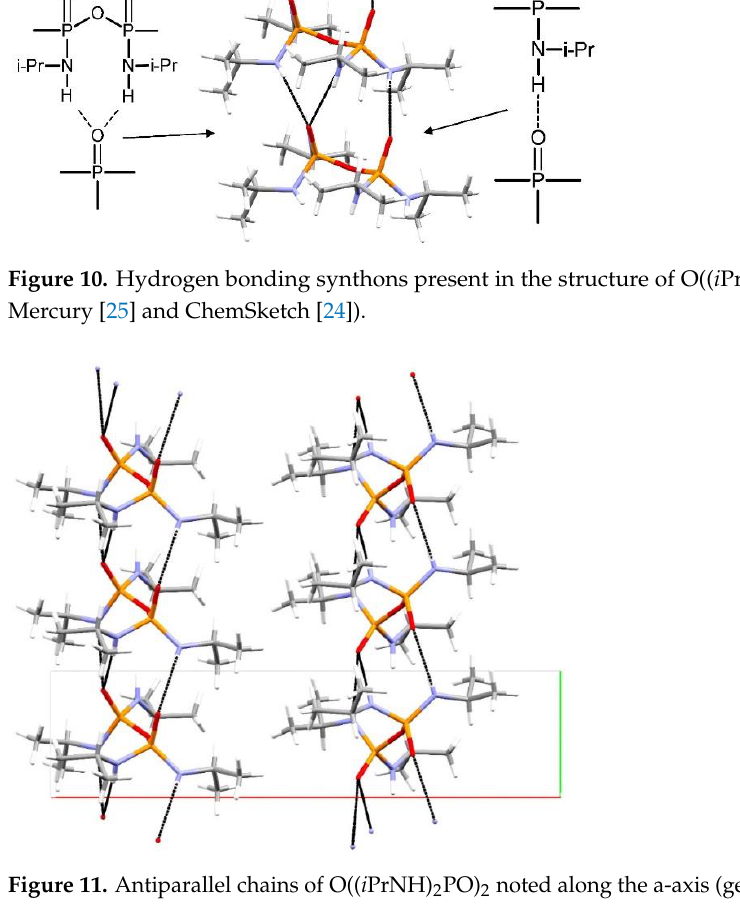
Figure 11. Antiparallel chains of O(( i PrNH) 2 PO) 2 noted along the a-axis (generated in Mercury [25]).